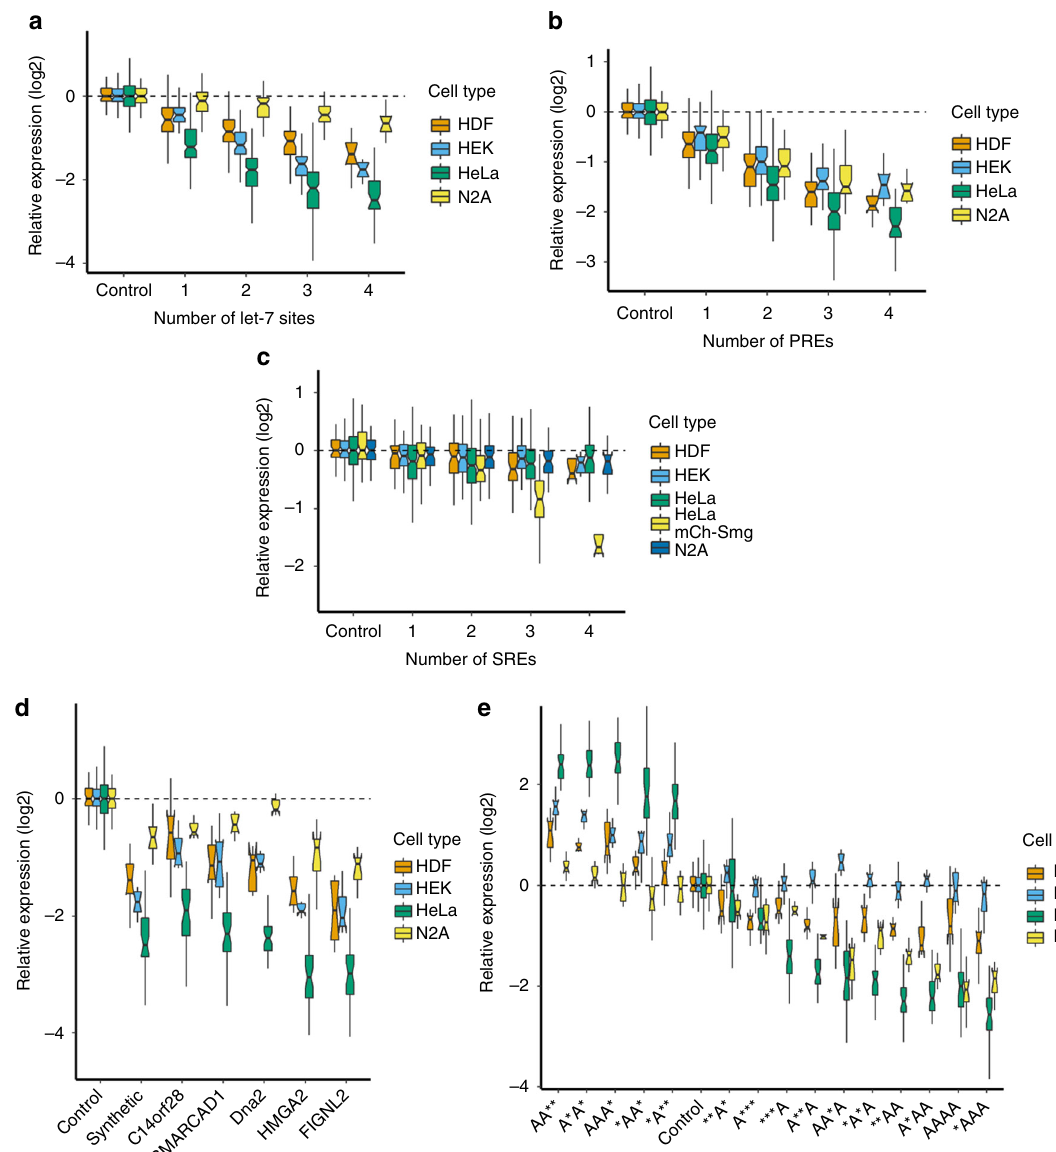
Fig. 6 The regulatory capacity of miRNAs and AU-rich elements vary across cell types The relative expression of reporters containing let-7 binding sites ( a ), PREs ( b ), SREs ( c ), natural binding sites for let-7 ( d ), or AREs ( e ). In panel c HeLa-mCh-Smg refers to HeLa cells that were cotransfected with the PTRE-seq library and a plasmid for expression of mCherry-Smaug. HDF, neonatal human dermal fi broblasts. HEK, human embryonic kidney. N2A, mouse neuro2A. For e * = Blank and A = ARE. Boxplot whiskers indicate the furthest datum that is 1.5*Q1 (upper) or 1.5*Q3 (lower). For clarity, outliers have been removed from boxplots but were used for statistical fi nding suggests the presence of a different pro fi le of active ARE- binding RBPs in each cell type.